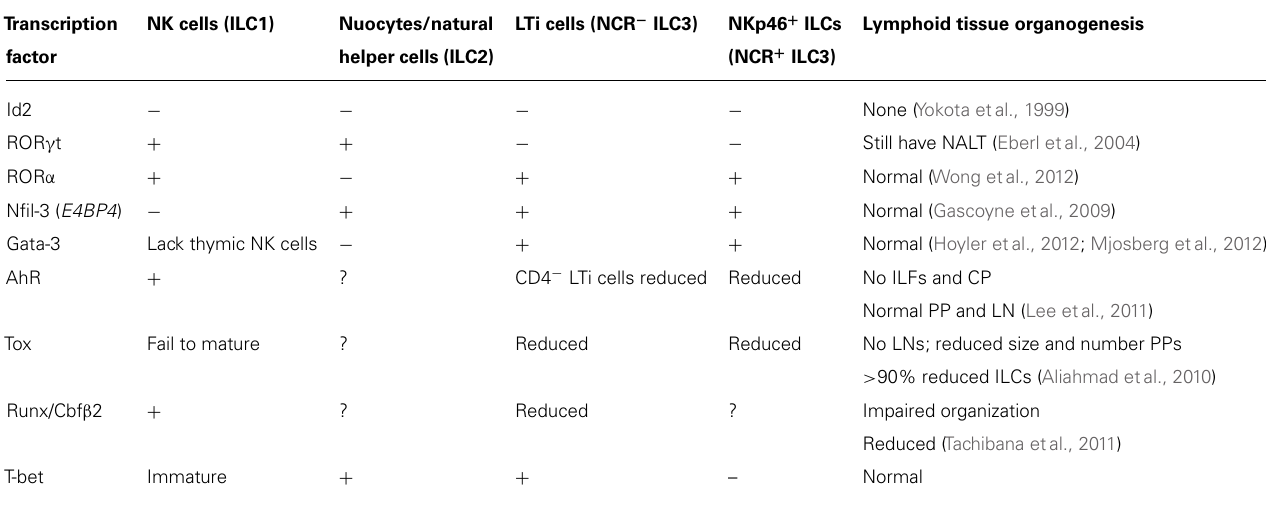
Table 1 | Requirement of different transcription factors for lymphoid tissue and ILC